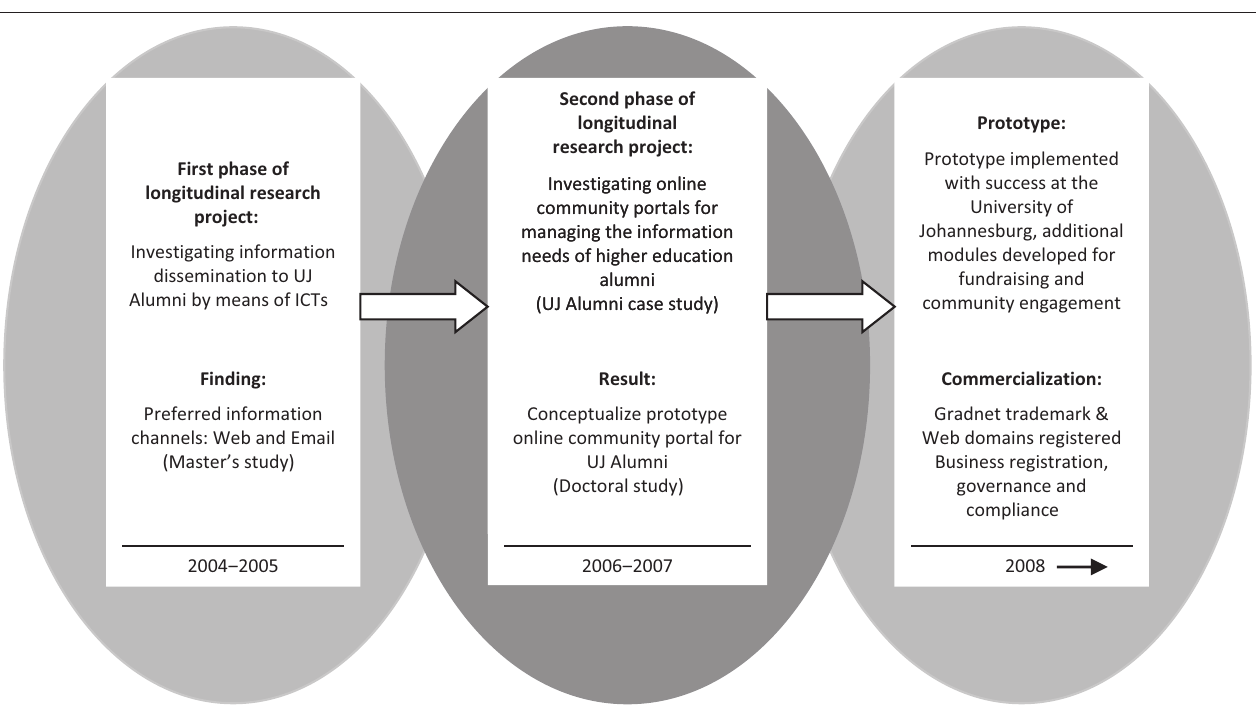
FIGURE 1: Phases of the longitudinal research project